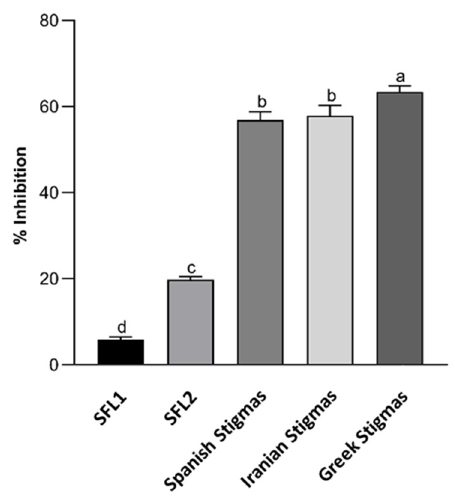
Figure 1. Iron (II) chelating activity of saffron floral-by products and saffron stigmas. The error bars represent the standard deviation and the different lowercase letters indicate statistically significant differences at p ≤ 0.05 for each sample ( n = 3). SFL1, SFL2: Saffron floral by-products from two different producers.